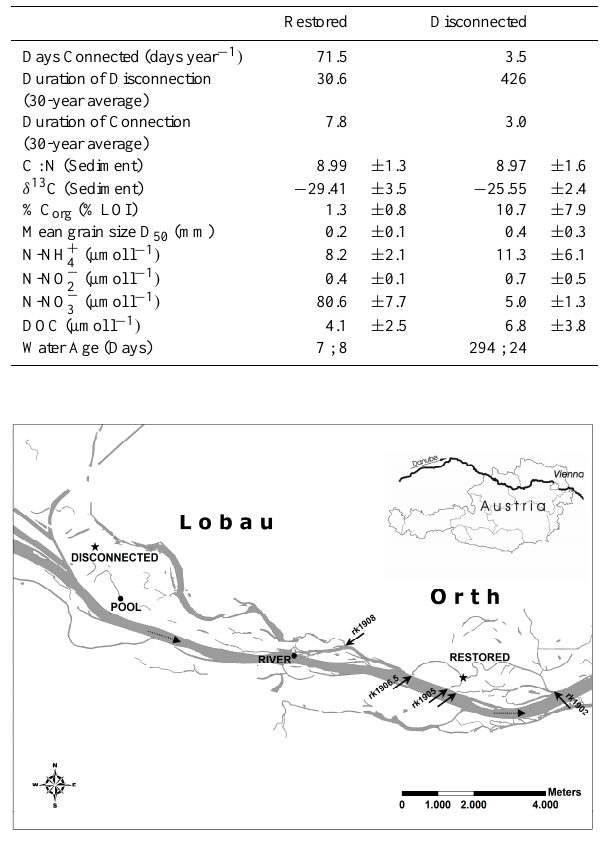
Fig. 1. Sampling sites are marked with stars; water exchange sites Figure 1. Sampling sites are marked with stars; water exchange sites for Experiment 2 are marked for Experiment 2 are marked with circles. Dashed arrows show the with circles. Dashed arrows show the flow direction; solid arrows mark the openings to flow direction; solid arrows mark the openings to the Danube River. the Danube River.